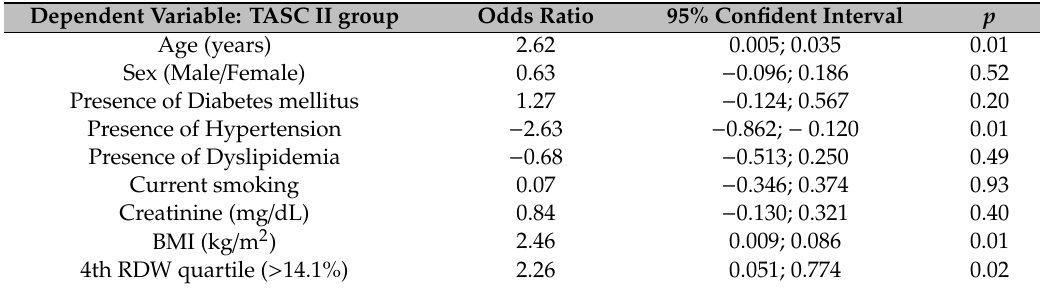
Table 3. Multivariate regression analysis for the reveal the predictor of PVD severity and